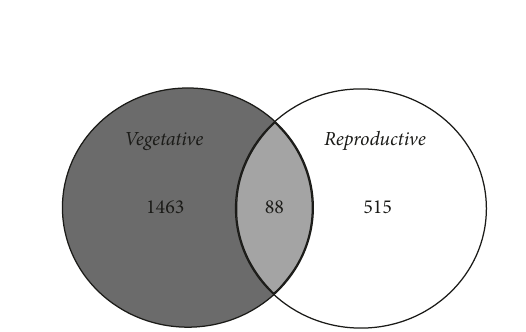
Figure 3: Venn diagram of 16S OTUs shared and unique to floodwater samples collected from vegetative and reproductive stages of rice plants. Sequences were classified into OTUs at 97% similarity using the average neighbor algorithm in